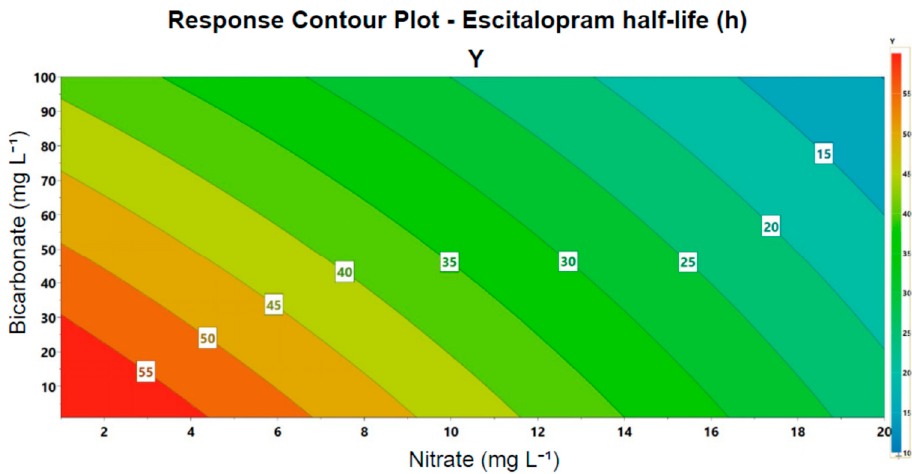
Figure 1. Contour plot of first ‐ order FFD model: ESC half ‐ life as a function of nitrate and bicarbonate concentrations.